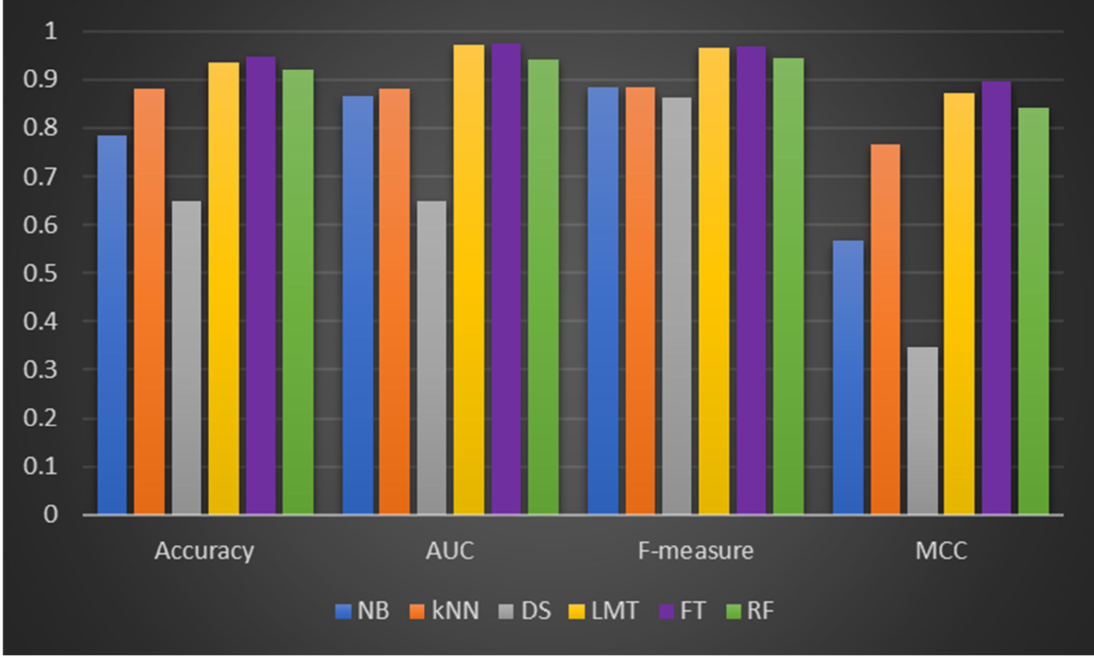
Figure 4. CCP Performance of DF models and ML Classifiers on balanced (SMOTE) Dataset